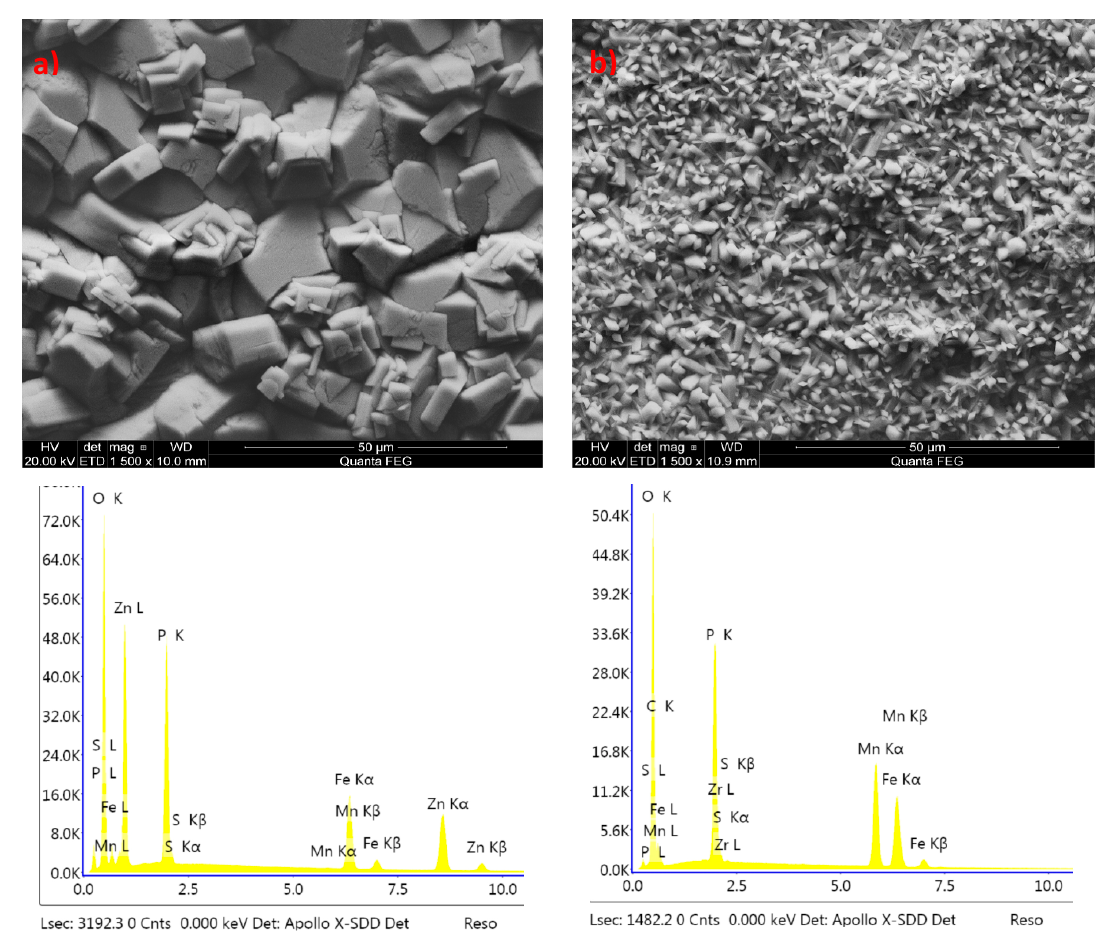
Figure 1. Standard reference coatings. scanning electron microscope (SEM) image with EDS: ( a ) zinc phosphate coating, ( b ) manganese phosphate coating.